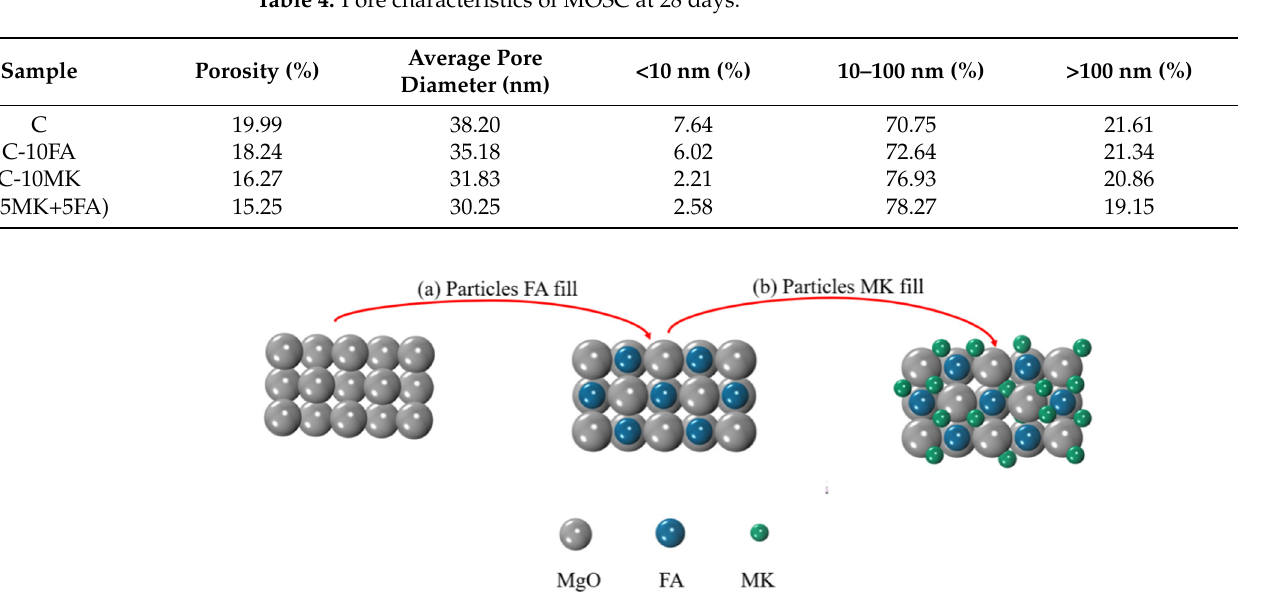
Table 4. Pore characteristics of MOSC at 28 days.